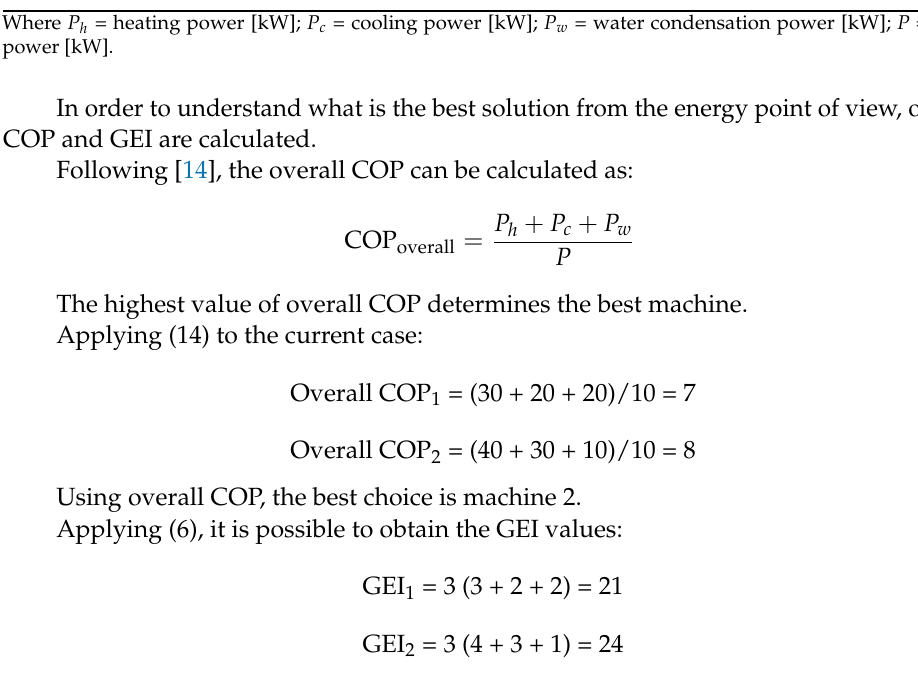
Table 1. Average performance characteristics of the two machines. P h [kW] P c [kW] P w [kW] P [kW] COP EER WET Machine 1 30 20 20 10